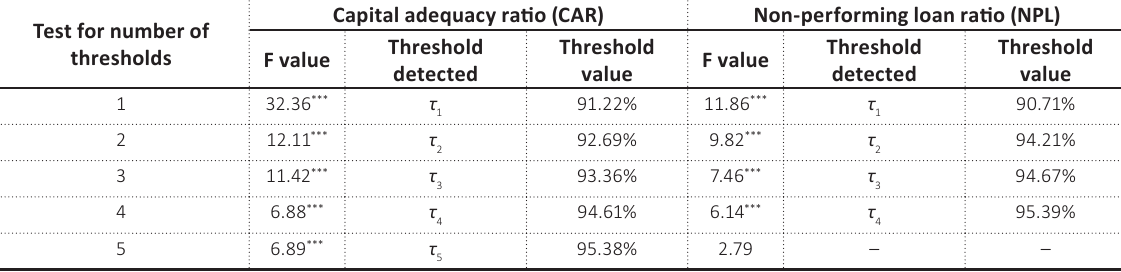
Table 4. Test for unknown thresholds of the debt ratio (DBT) Test for number of thresholds